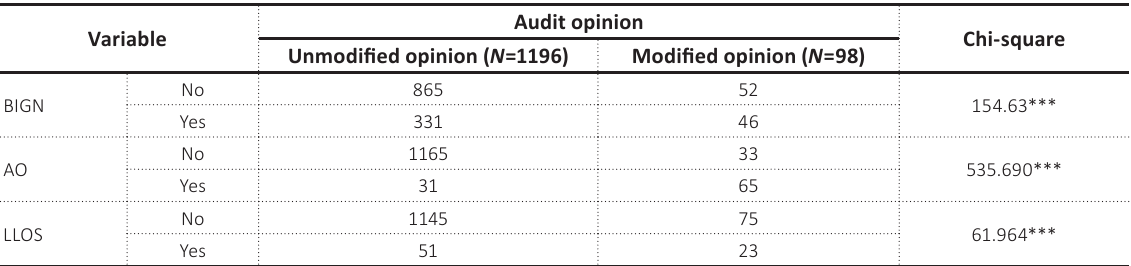
Table 2. Descriptive statistics for binary